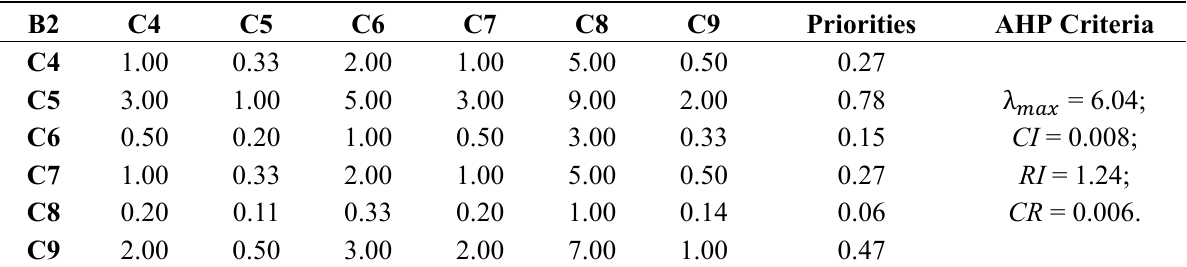
Table 4. Judgment matrix of the criterion B2 and its related factors.